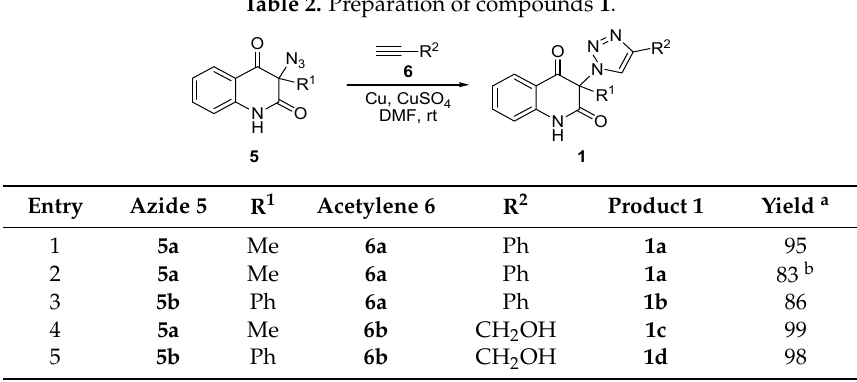
Table 2. Preparation of compounds 1 .